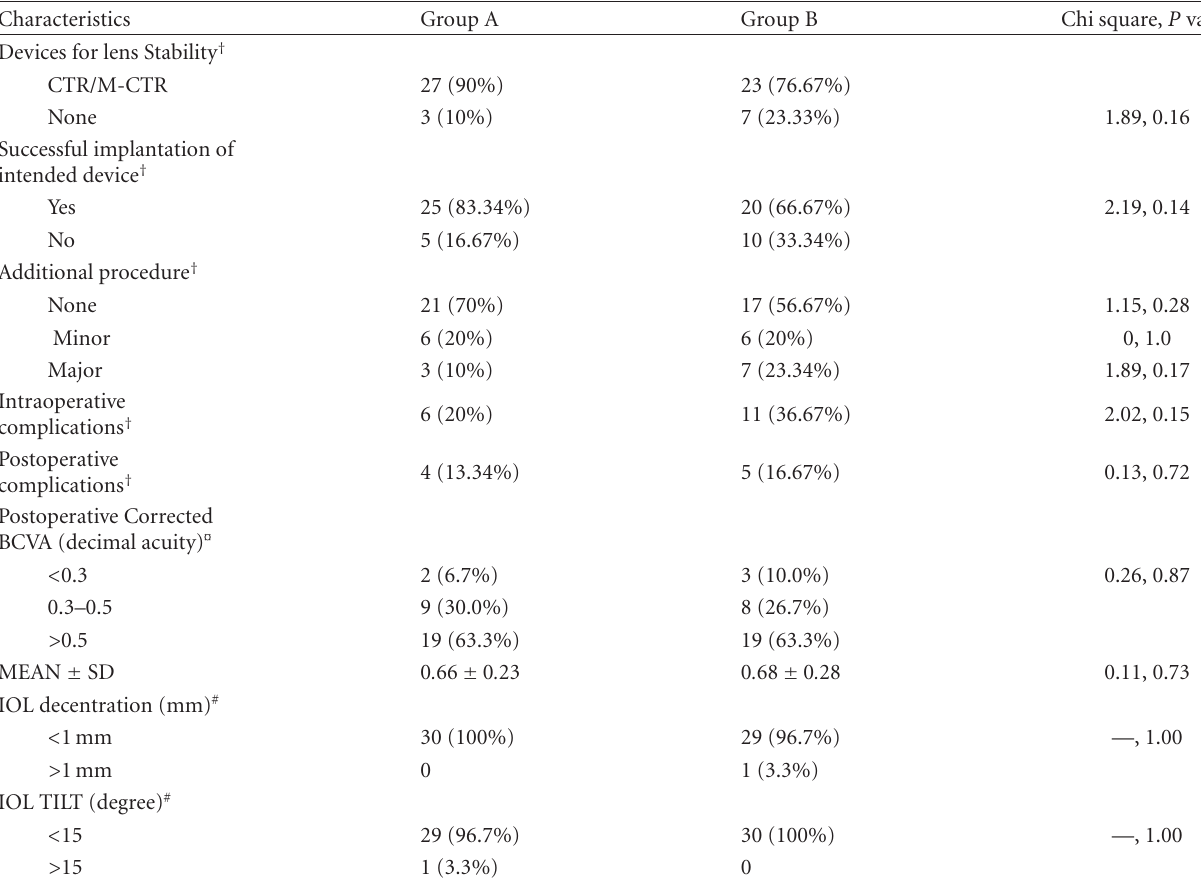
Table 2: Postoperative comparison of two